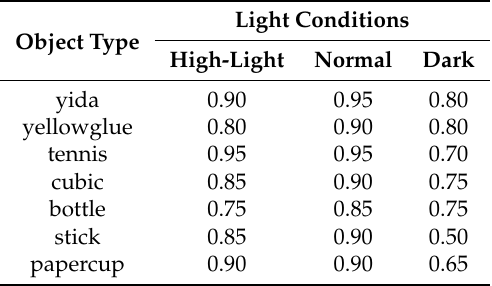
Table 3. Mobile manipulation success rate for different objects in different light conditions